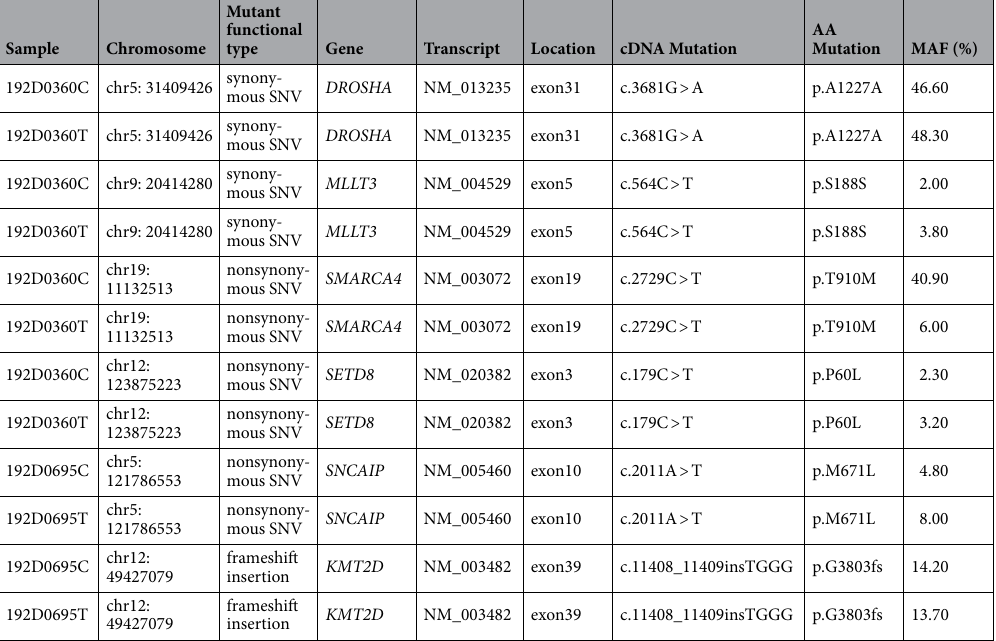
Table 3. The shared alterations detected from CSF and tumor tissue in 9 cases. C, CSF supernatant; T, Tumor tissue; MAF, Mutant allele fraction; AA, Amino acid.